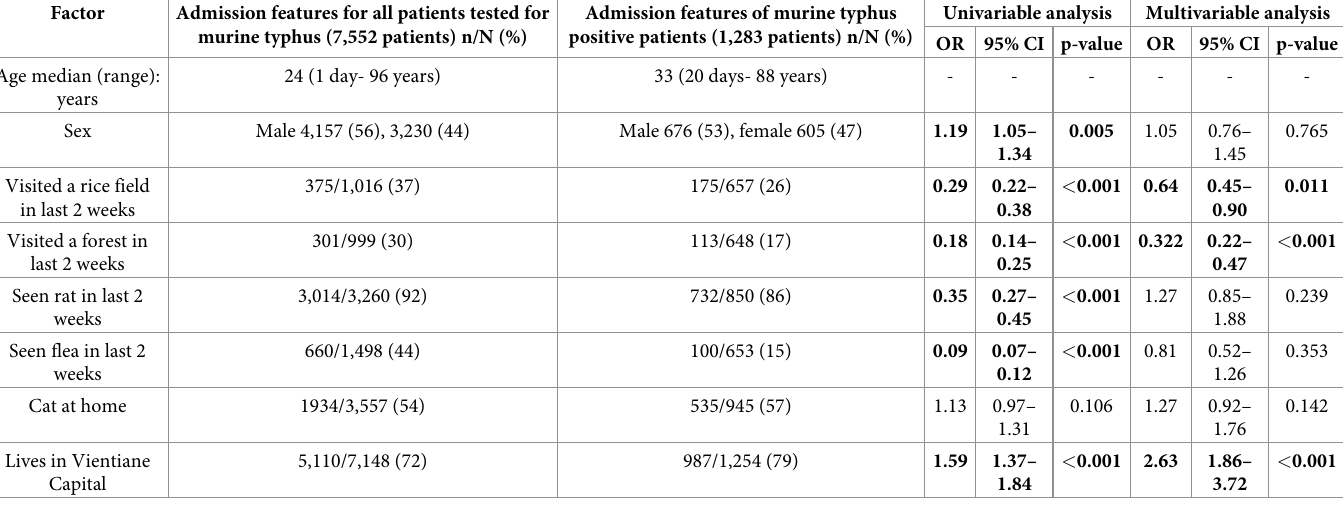
Table 2. Univariable and multivariable logistic regression for factors associated with murine typhus positive patients for all patients tested for murine typhus by RDT. n = number of patients with feature, N = number of patients with result (%). The data from all individual patients were included in the study although denominators vary for different parameters due to incomplete